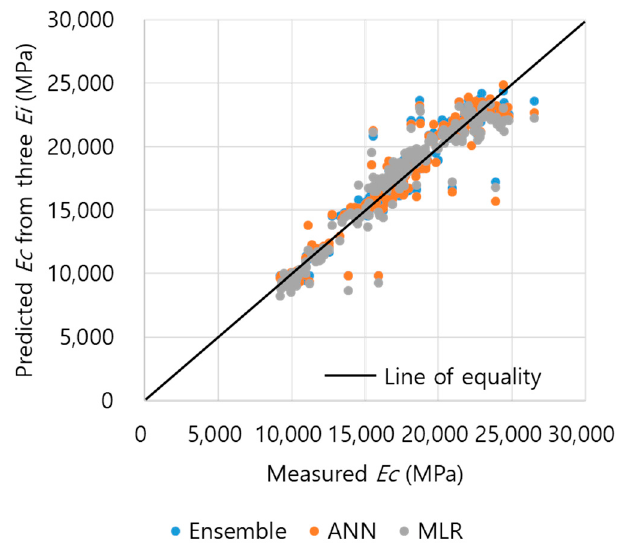
Figure 15. Comparison of Ec predicted with Ei and actual Ec.